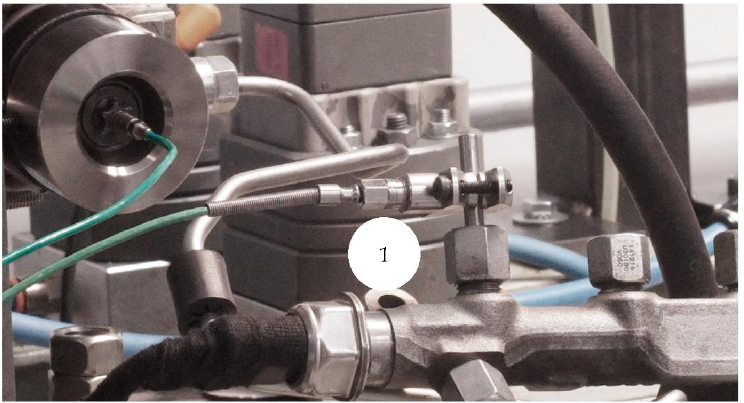
Figure 3. (1) PT-Inlet pressure sensor; (2) Head-cover provided with PT-Inlet pressure sensor; (3) Pump-head with inlet valve; (4) detail view of disassembled sensor and head-cover. With reference to Figure 4, PT-Rail sensor (1) is installed on a blind injection pipe connected to the rail.